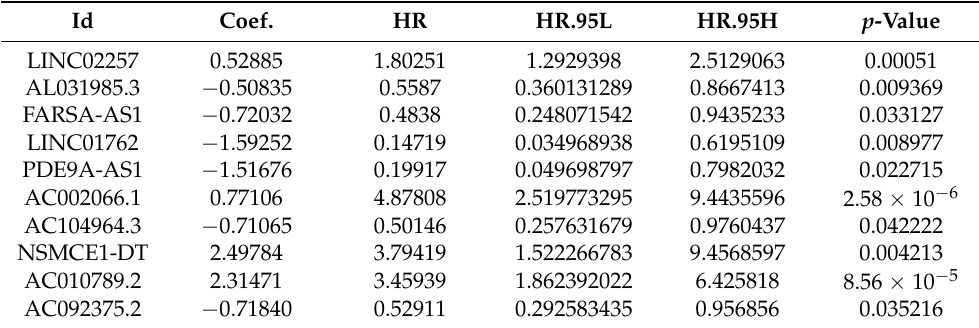
Table 1. Multivariate Cox results for cuproptosis-related long non-coding RNA based on The Cancer Genome Atlas—colon adenocarcinoma